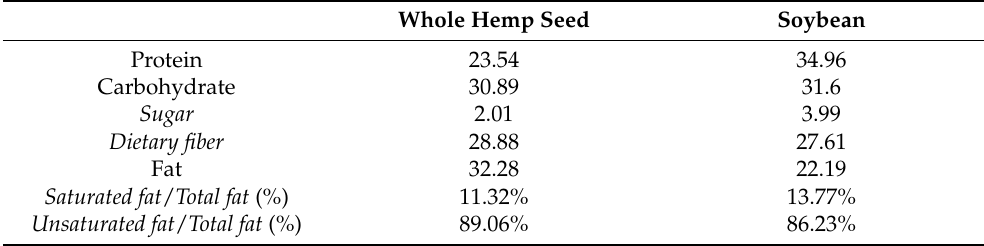
Figure 1. Whole ( a ) and dehulled hemp seed ( b ). Hemp flour ( c ). Table 1. Comparison of nutritional components between hemp seed and soybean.